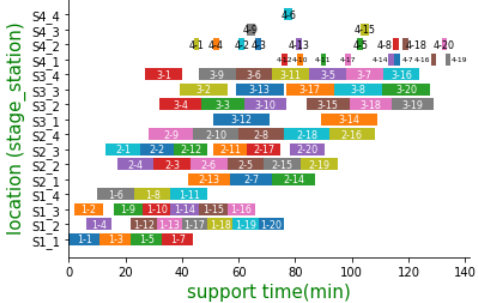
Figure 7. Gantt chart of optimal scheduling of aircrafts.